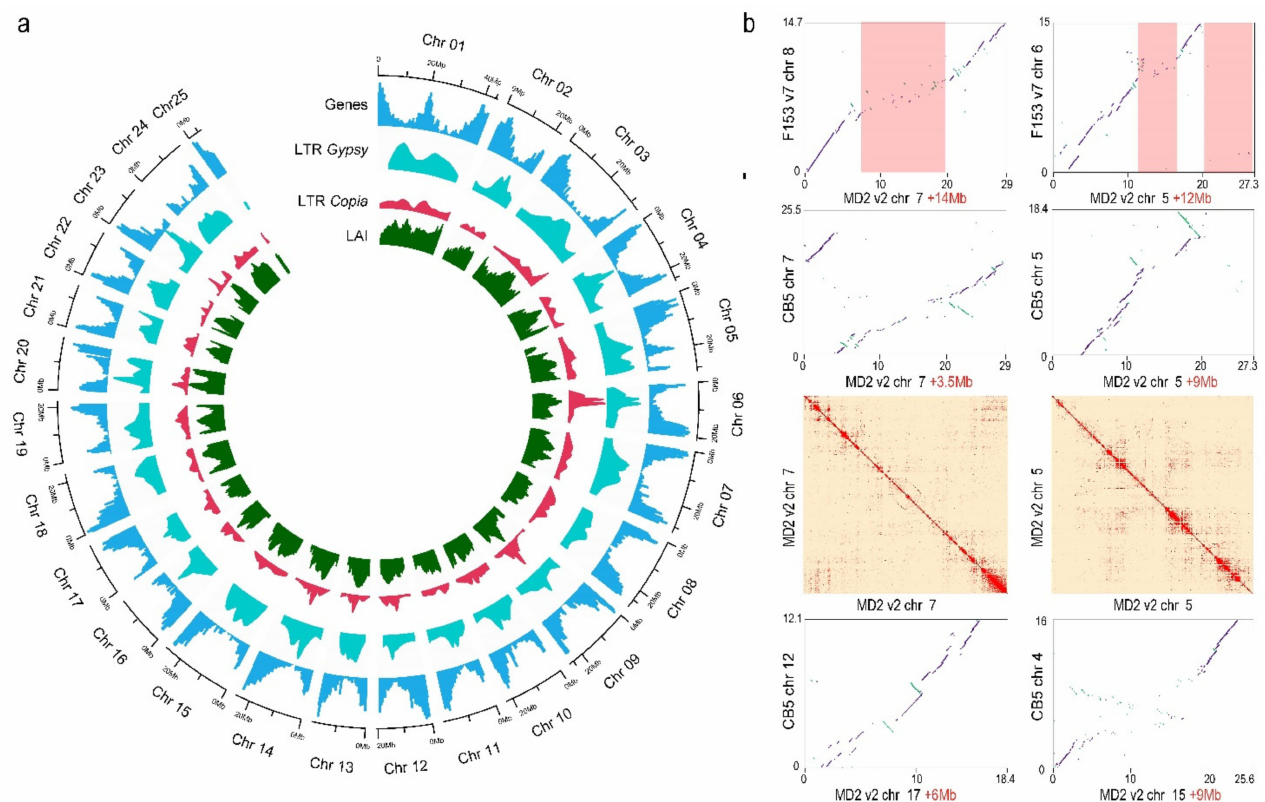
Figure 1. MD2 v2 P0 genomic features’ landscape and comparative analysis. ( a ) CIRCOS plot illustrating the location/density of gene models, Ty3/Gypsy LTR, Ty1/Copia LTR, and LTR Assembly Index (LAI) score along the MD2 v2 P0 assembled chromosomes; ( b ) Visual representation of the quality of the MD2 v2 genome compared to other high-quality pineapple genomes (F153 v7 and CB5). Numbers in the x and y axes represent Mb sequences. Additional sequences assembled in MD2 v2 were primarily located in regions with high amounts of repeats (i.e., centromeres, highlighted with red shaded boxes). Contiguous interaction along the Hi-C plot validates the quality of the newly assembled regions. In each chromosome comparison, the number highlighted in red indicates the additional sequences assembled in the MD2 v2